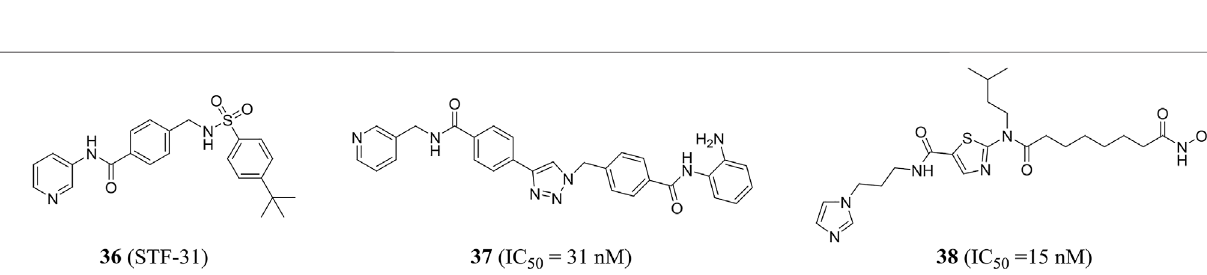
Frontiers in Pharmacology |